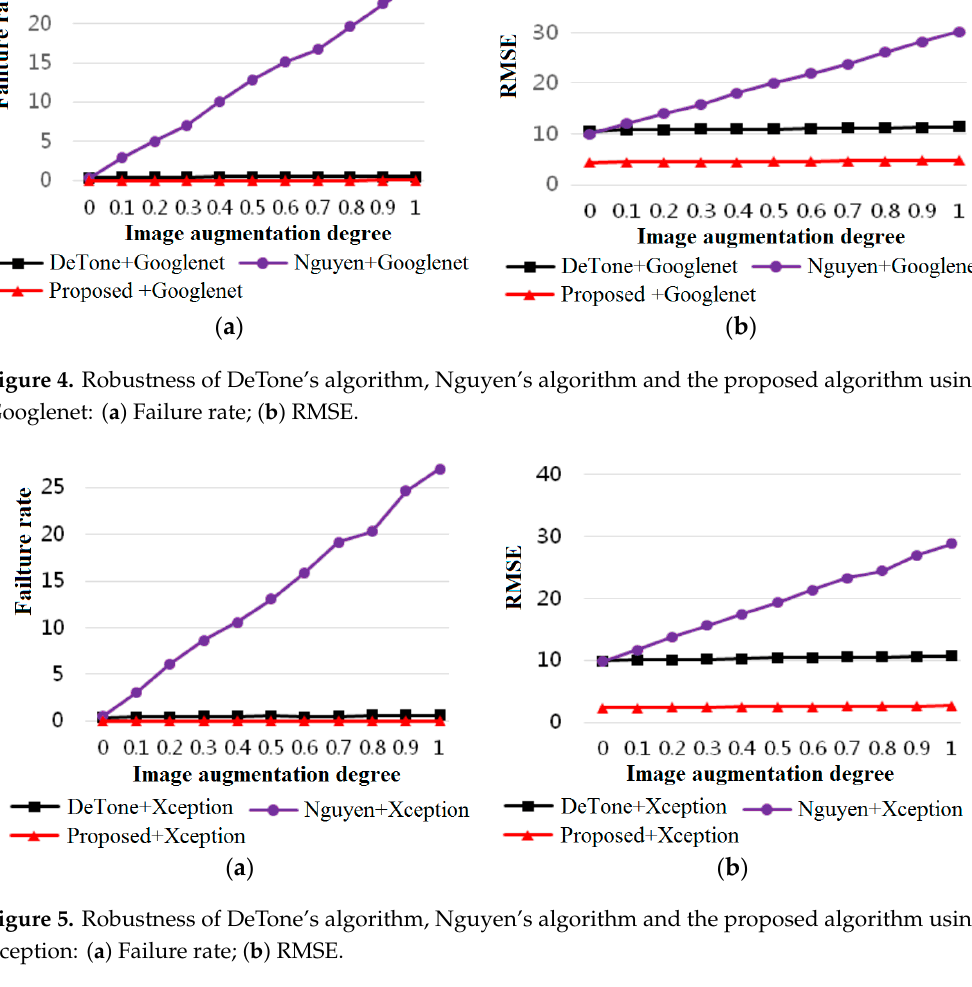
Xception: ( a ) Failure rate; ( b ) RMSE.